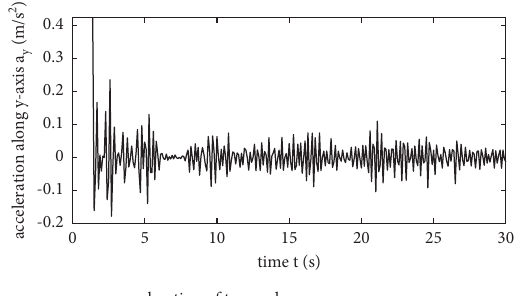
Figure 10: Acceleration of top node (o) along the (y)-axis with ignoring the step effect of gravitational acceleration at the initial moment.